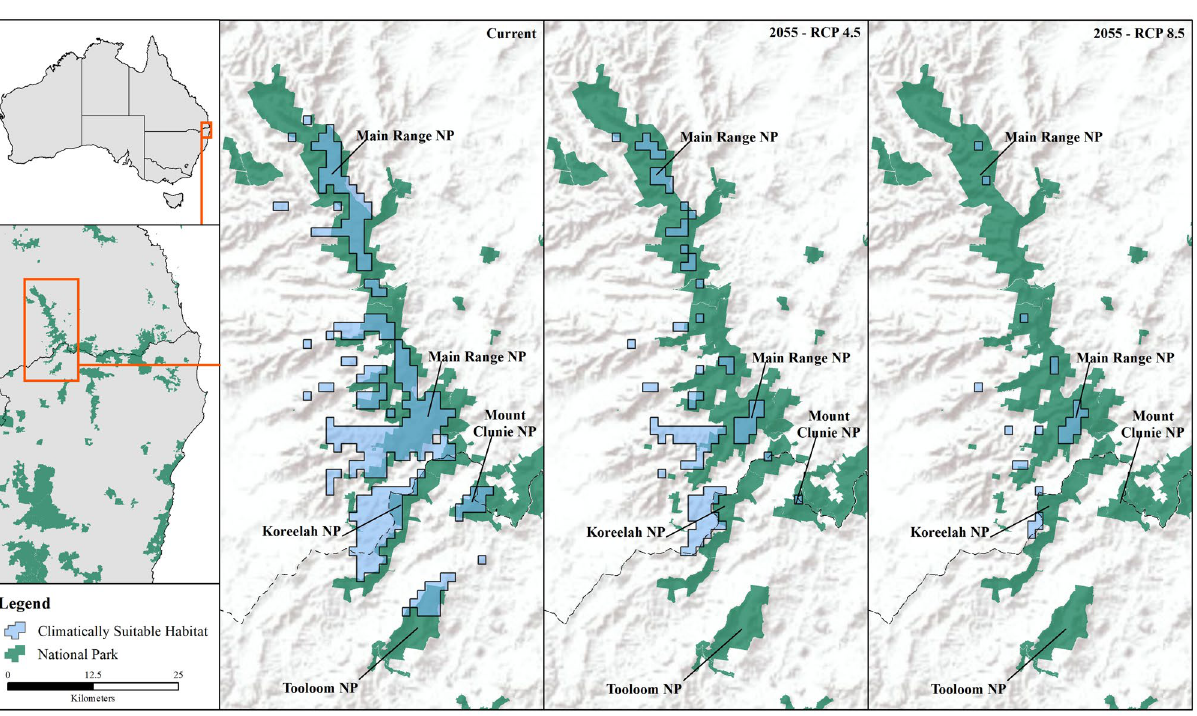
Figure 2. Predicted distribution of P. kundagungan under current conditions and, RCP4.5 and RCP8.5 climate scenarios in 2055. This figure was produced using ArcMap 10.4.1, https:// www. esri. com/ en- us/